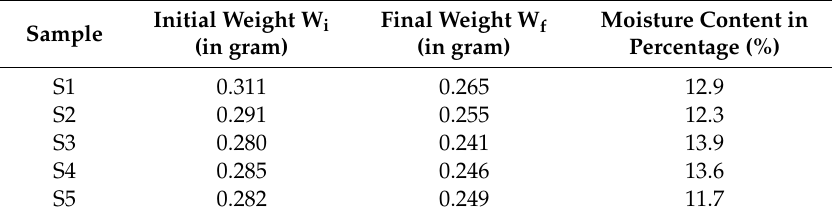
Table 5. Moisture content of thermoplastic starch